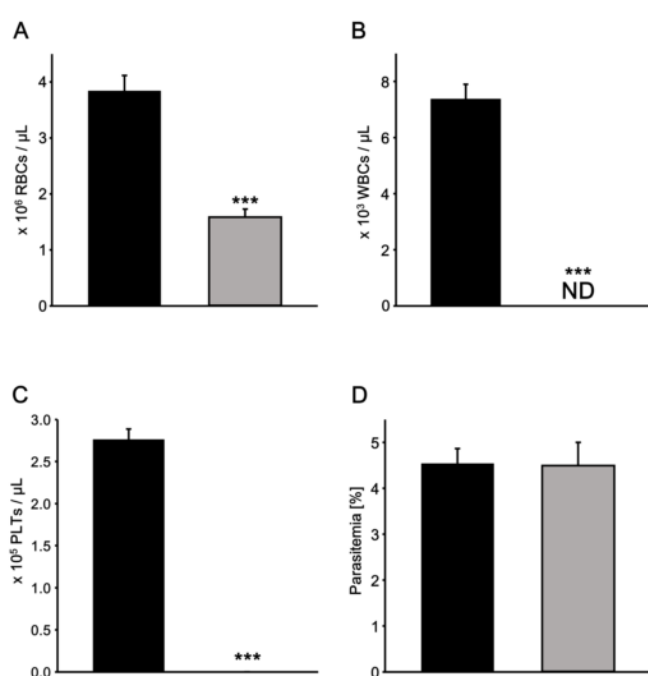
Figure 3. Evaluation of spin columns for the filtration of whole blood and parasite culture. The number of erythrocytes ( A ), leucocytes ( B ), or platelets ( C ) was analysed before (black bars) or after (grey bars) filtration of whole blood. Parasitemia of in vitro culture was determined before or after filtration ( D ). *** p < 0.001 (Student’s t -test, n = 5). Microorganisms 2020 , 8 , x FOR PEER REVIEW